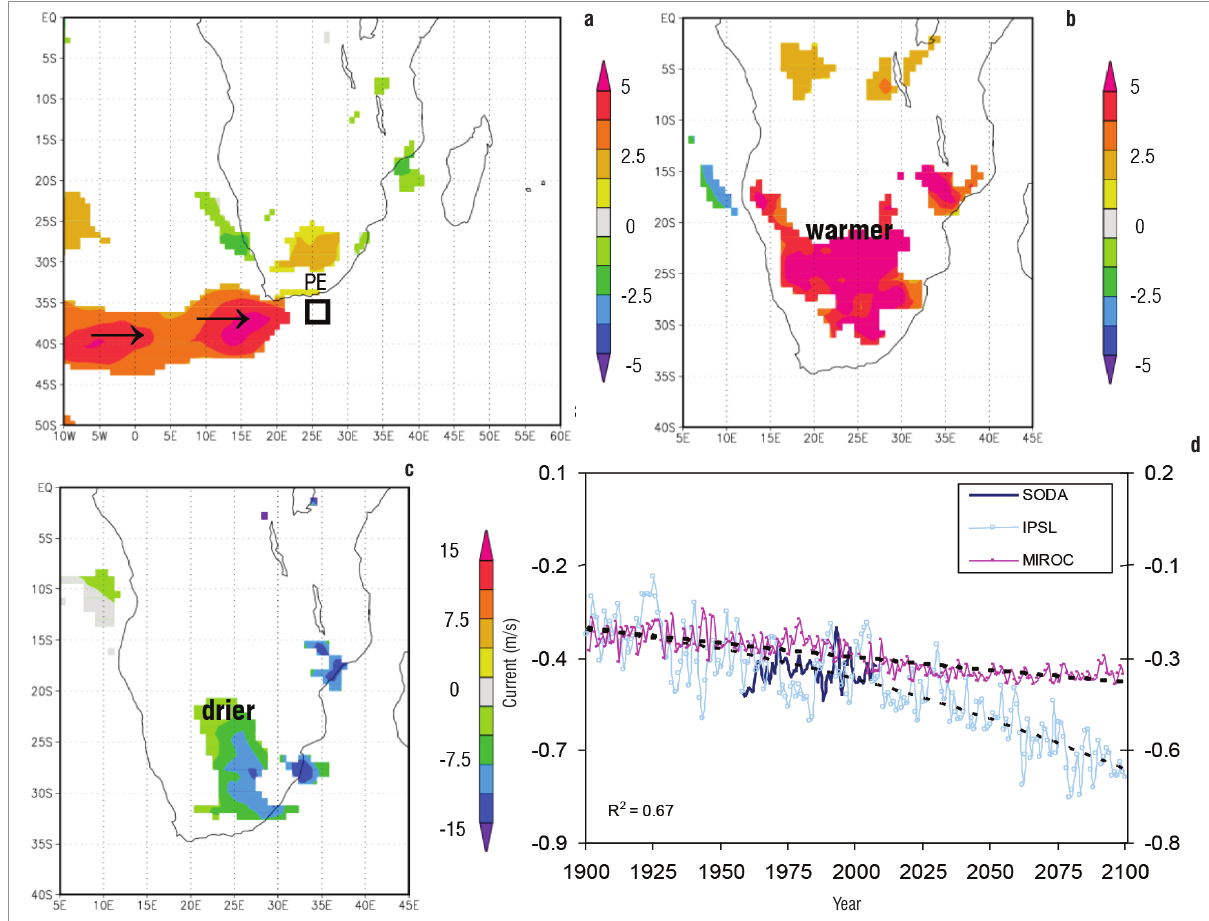
Figure 8: Regression of SODA 0–200 m zonal current (in box) with (a) surface zonal wind (m/s per m/s), (b) surface air temperature (°C per m/s) and (c) rainfall (mm/day per m/s) from ECMWF for the period 1979–2005; with areas <90% confidence masked. (d) Time series of 0–200 m zonal current from SODA reanalysis and IPSL and MIROC A1B simulations in the box in (a) south of Port Elizabeth